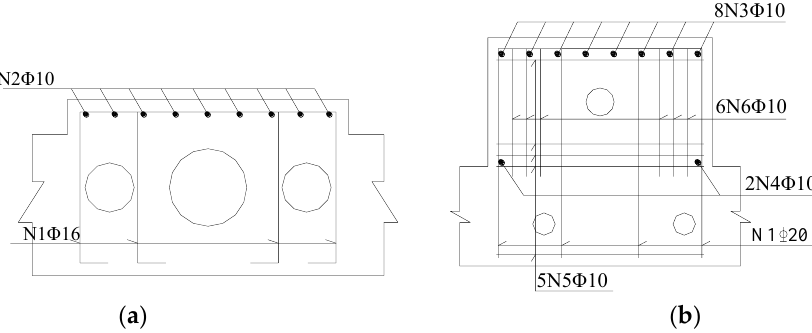
Figure 7. Schematic diagram of reinforcing steel bar under anchor: ( a ) top slab (A-A–B-B); and ( b ) bottom slab (B-B–D-D).